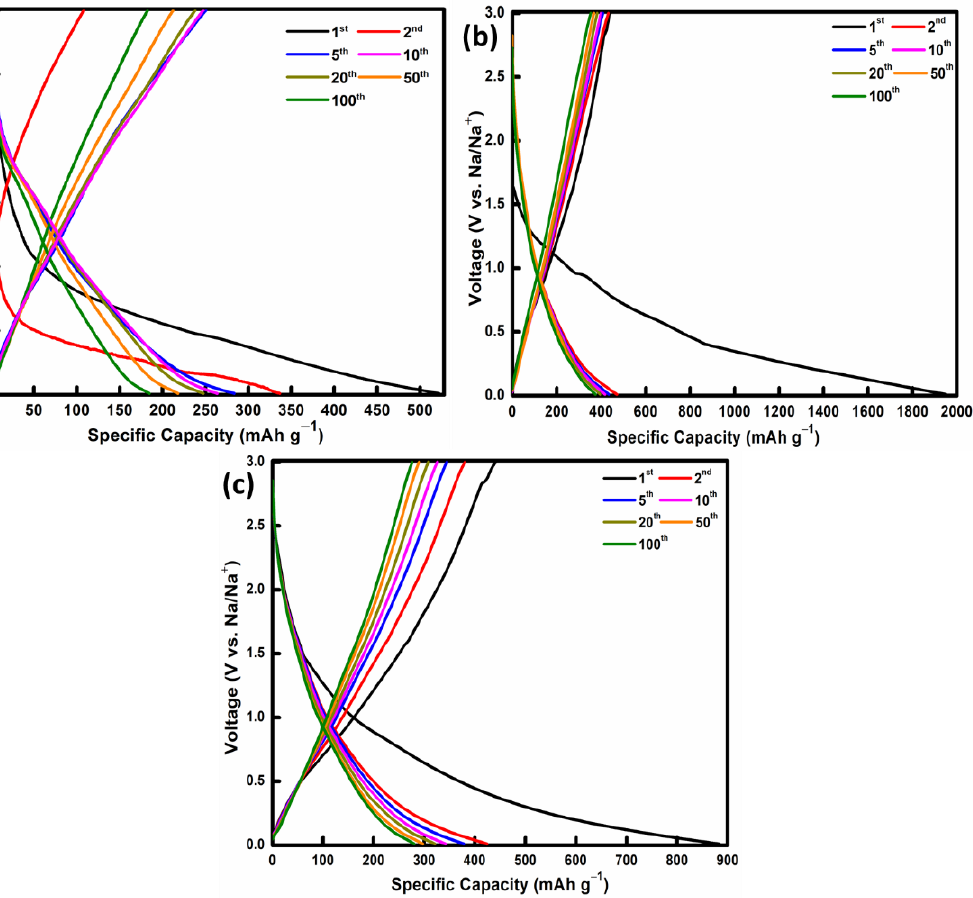
Figure 9. Charge/discharge profiles at selected cycles for ( a ) Mn 3 O 4 nanoparticles, ( b ) Mn 3 O 4 /N-rGO aerogel, and ( c ) Mn 3 O 4 /N, S-rGO aerogel. rGO aerogel, and ( c ) Mn 3 O 4 /N, S-rGO